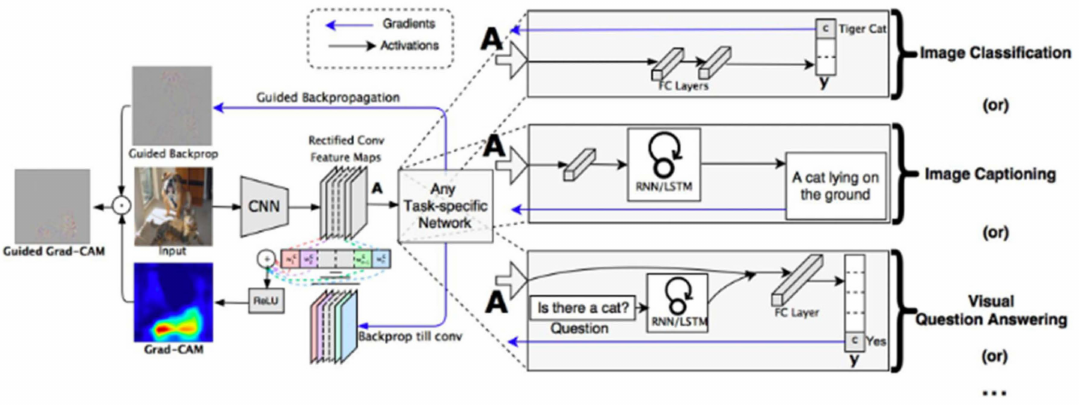
Figure 11. Overview of Grad-CAM for Image classification, captioning, and Visual question